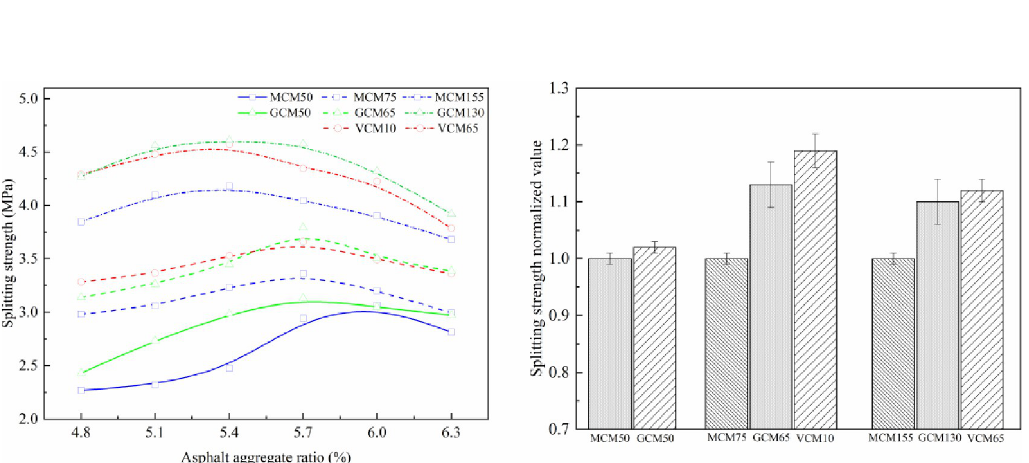
Fig 9. Effect of compaction on shear strength under different compaction methods. (a) Shear strength versus asphalt-aggregate ratios (b) Shear strength normalized value.